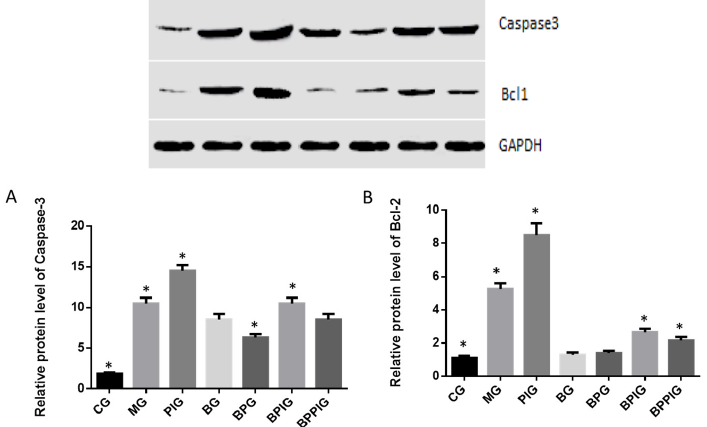
Figure 12. Western blot analysis of the protein levels of casepase ‐ 3 and Bcl ‐ 2. Eight liver samples